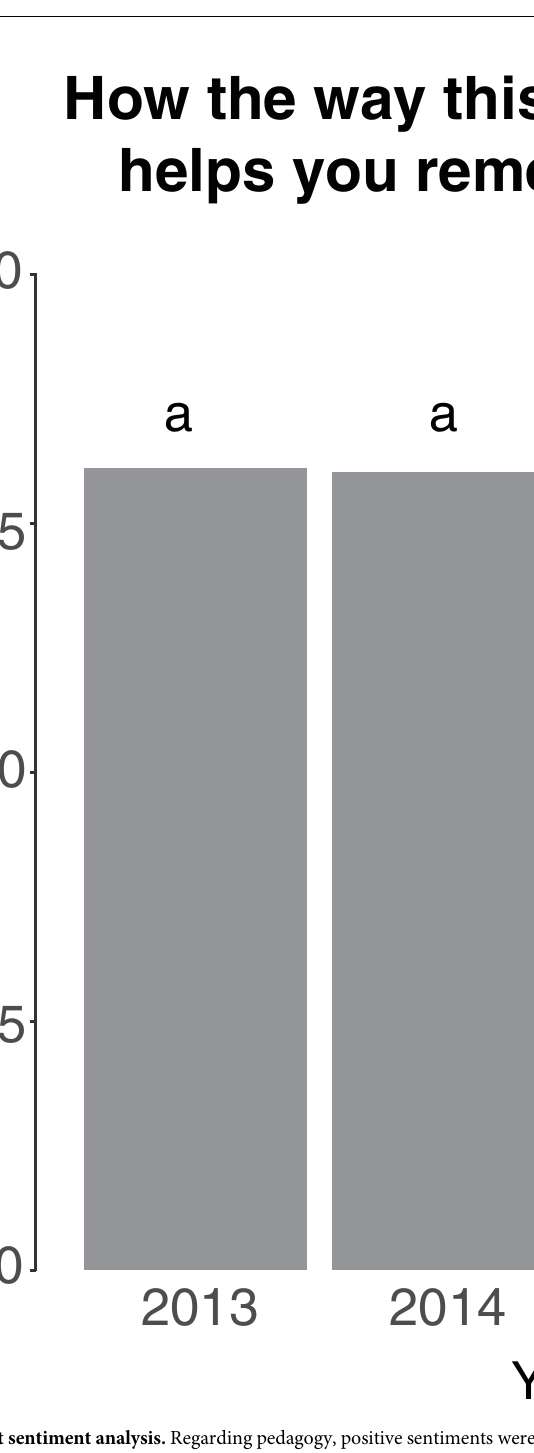
Fig 4. Student sentiment analysis. Regarding pedagogy, positive sentiments were more abundant than negative sentiments in all years, and this proportion was higher in the latter two years ( p < 0.0001). Sentiments were assigned to trigrams (three consecutive words) that were extracted from a free-response survey